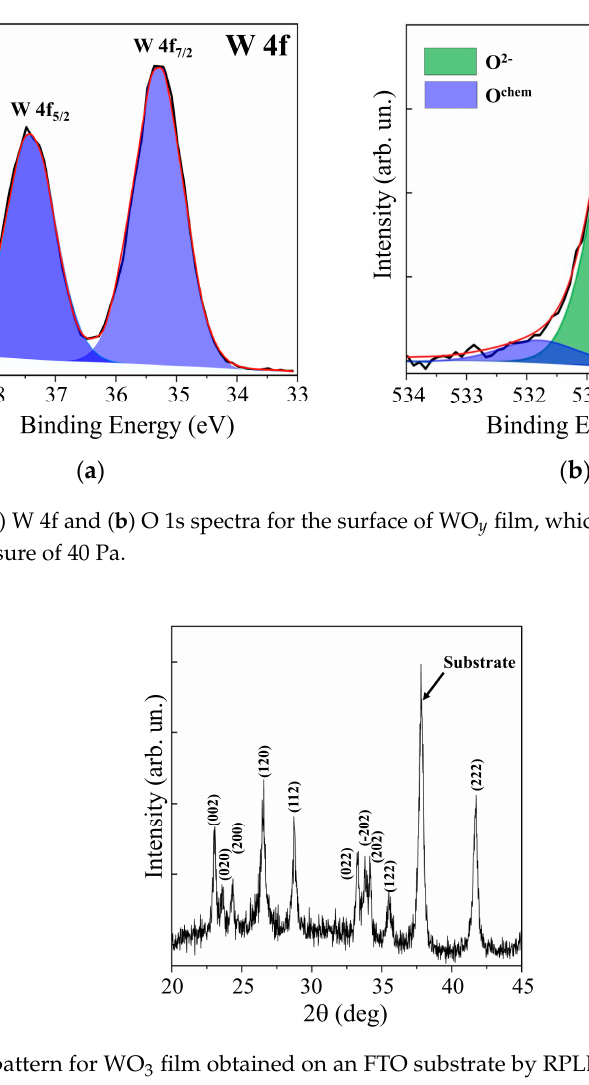
( b ) Figure 1. Experimental ( a ) RBS and ( b ) Raman spectra for the WO y films obtained on an FTO substrate by RPLD at different pressures of dry air. MRS studies of WO y films showed (Figure 1b) that a fairly perfect crystalline structure of WO y films was formed at dry air pressures of 40 and 60 Pa. This was indicated by the peaks characteristic of the WO 3 monoclinic phase at 271.8, 722.3, and 806.7 cm − 1 [36,37]. In this case, no obvious differences in the MRS spectra of these films were observed. At lower dry air pressure (20 Pa), the Raman spectrum of the WO y film consisted of several broadened bands; this pointed to a strongly disordered/amorphous structure of the film. Based on the results of RBS and MRS studies, it was decided to use WO y films obtained at an air pressure of 40 Pa to form photocatalytic heterostructures. At that dry air pressure, the formation of sufficiently perfect crystalline films was observed under the condition of the highest rate of their deposition by RPLD. Additional studies of WO y films by XPS showed (see Figure 2) that, in the case of RPLD at a dry air pressure of 40 Pa, quite effective oxidation of W atoms occurred. The XPS spectrum analysis of W 4f revealed the dominance of W 6+ states with binding energies for W 4f 7/2 − 4f 5/2 peaks equal to 35.3 and 37.4 eV. The О 1s peak corresponding to О‒ W states was located at a binding energy of 530.4 eV. The peak at 531.8 eV arose from O-containing surface contaminants. These parameters of XPS spectra for WO y films indicated the formation of a fairly perfect WO 3 compound [37–39]. The calculation of